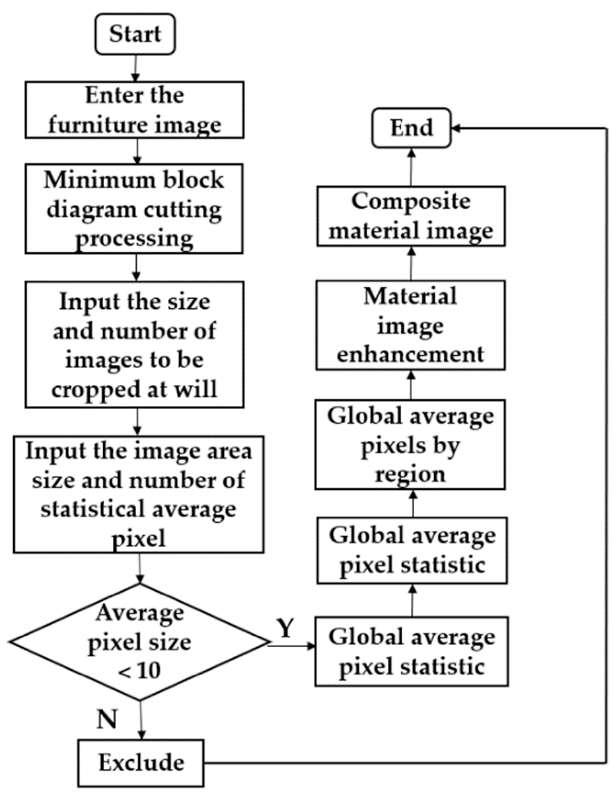
Figure 4. Framework diagram of the texture map restoration method.